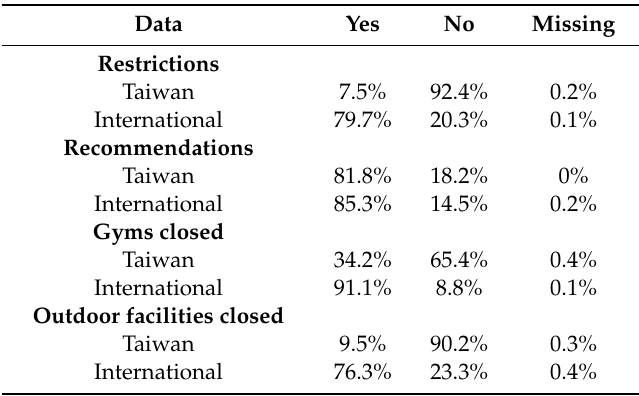
Table 2. Participants’ report on governmental restrictions and recommendations, and the status of the recreational facilities in Taiwan vs. international